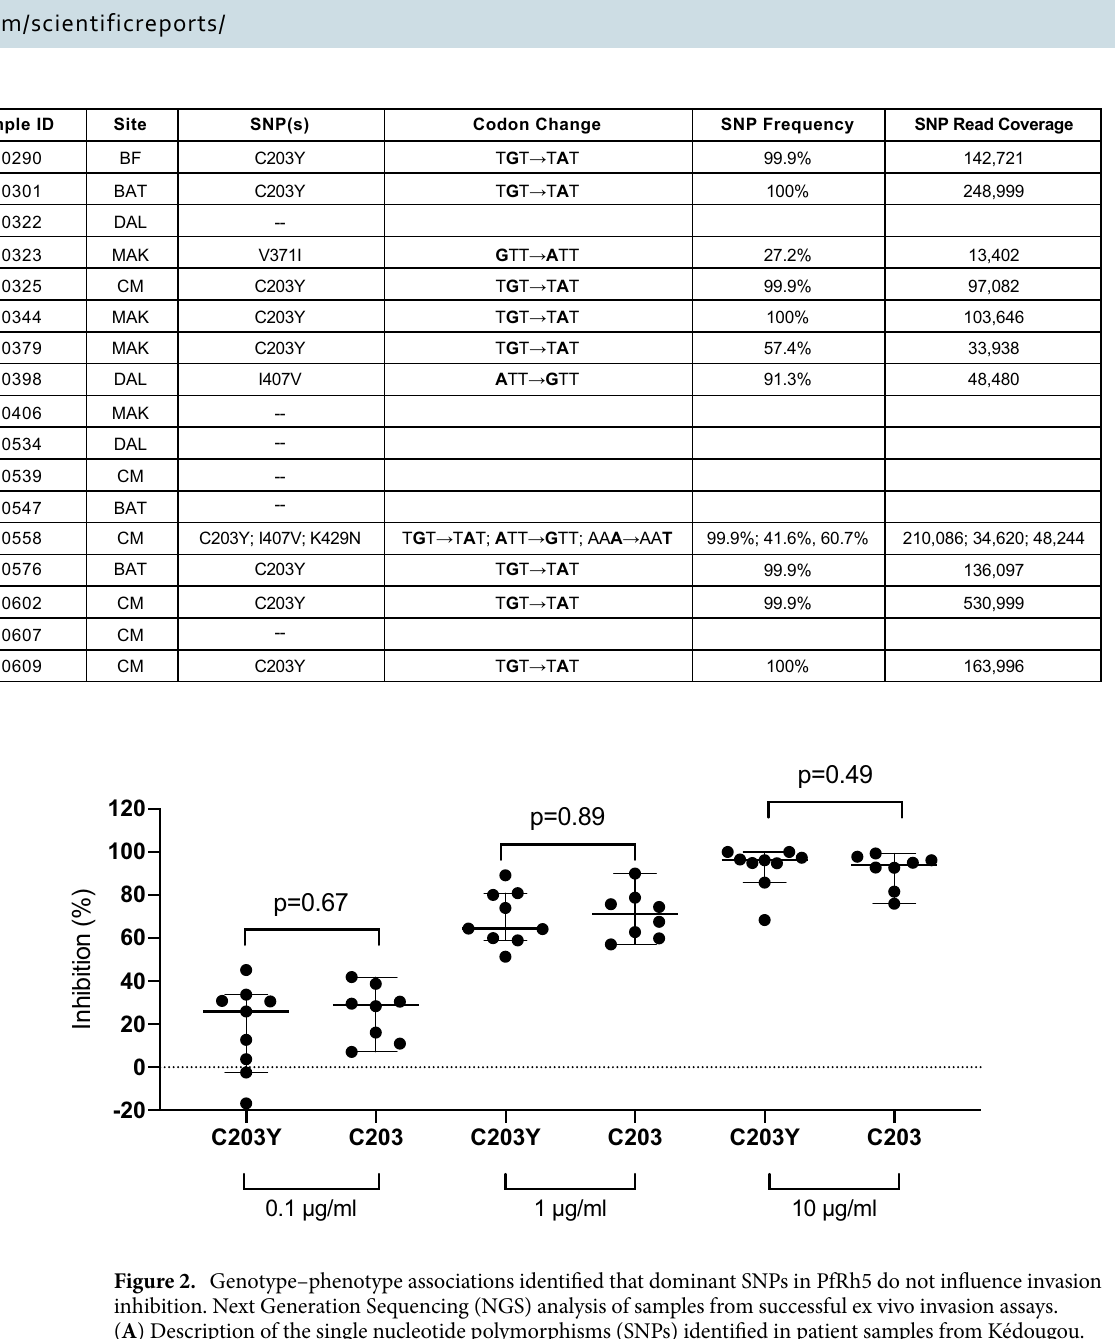
as a strength in reflecting the reality of the field. Demonstrating that anti-BSG antibodies can significantly inhibit invasion across a genetically diverse parasite population provides a realistic idea of the potential success of a neutralizing antibodies from a PfRh5 vaccine in patients living in endemic regions.